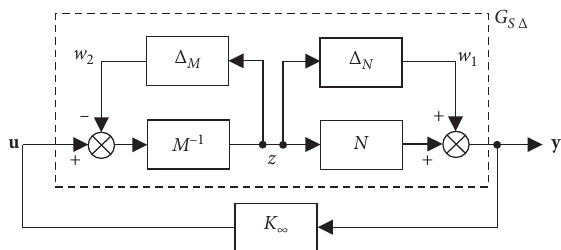
∞ loop-shaping design.